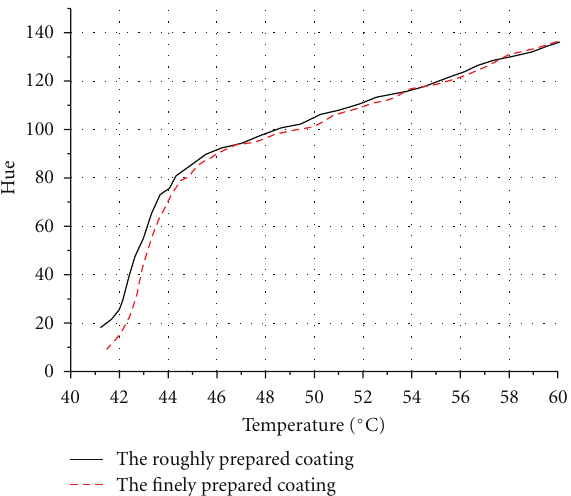
Figure 8: The hue curves comparison between the rough and fine TLC coatings.